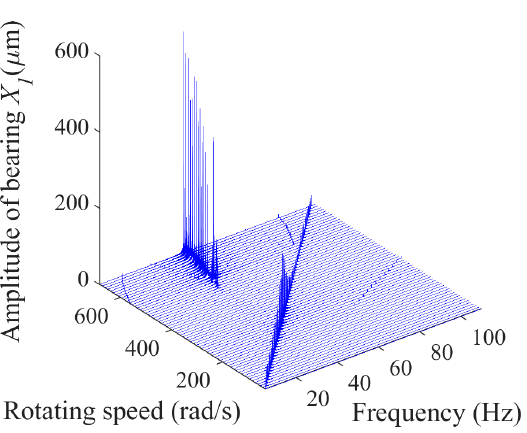
Figure 9. Three-dimensional spectrum waterfall diagram of a dual-rotor system.